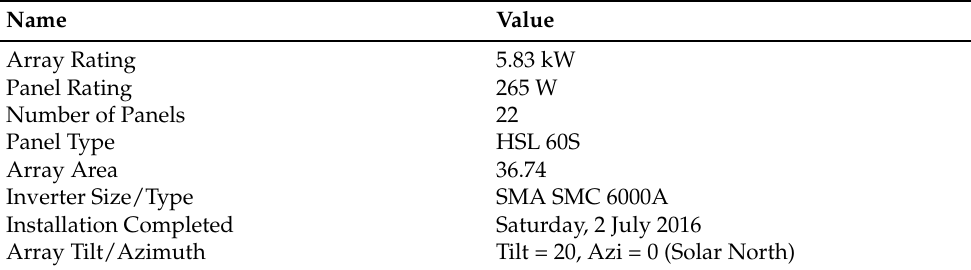
Table 2. Information on the main characteristics of the solar